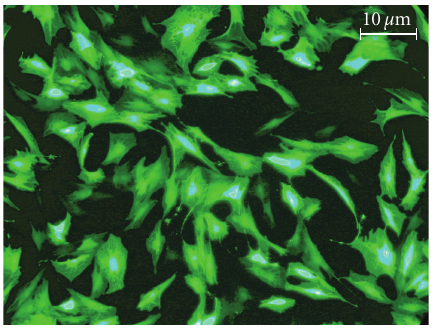
Figure 3: E ffi cient adenoviral-mediated transduction of ATSC. ATSCs were transfected with 100 pfu/cell of AdEGFP and fluores- cent cells were observed after 48 hours: nearly 80% cells were EGFP- positive as shown in the